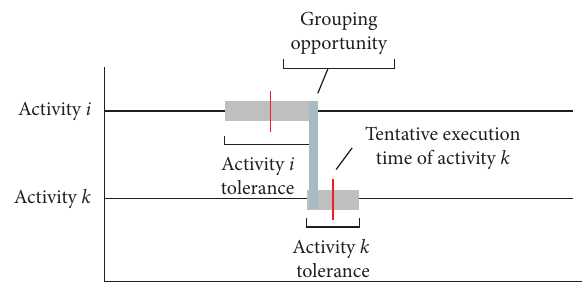
Figure 1: Feasibility of opportunistic grouping between the ac- tivities i and k .